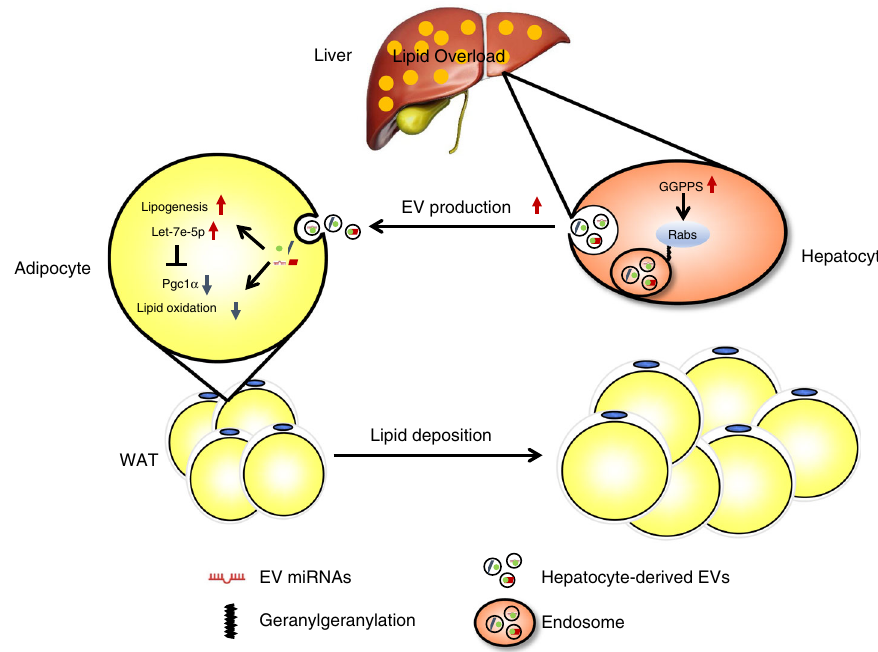
Fig. 8 Schematic for the contribution of hepatic EVs to adipose remodelling. Induced Ggpps expression in hepatocytes by acute and chronic HFD consumption gives rise to hepatocyte-derived EV secretion through Rab27A geranylgeranylation, which remodels adipose tissue via adipogenesis and lipogenesis. Hepatocyte-derived EVs containing miRNAs enhance lipid deposition in adipocytes by increasing lipogenesis and inhibiting lipid oxidation through the let-7e-5p-Pgc1 α